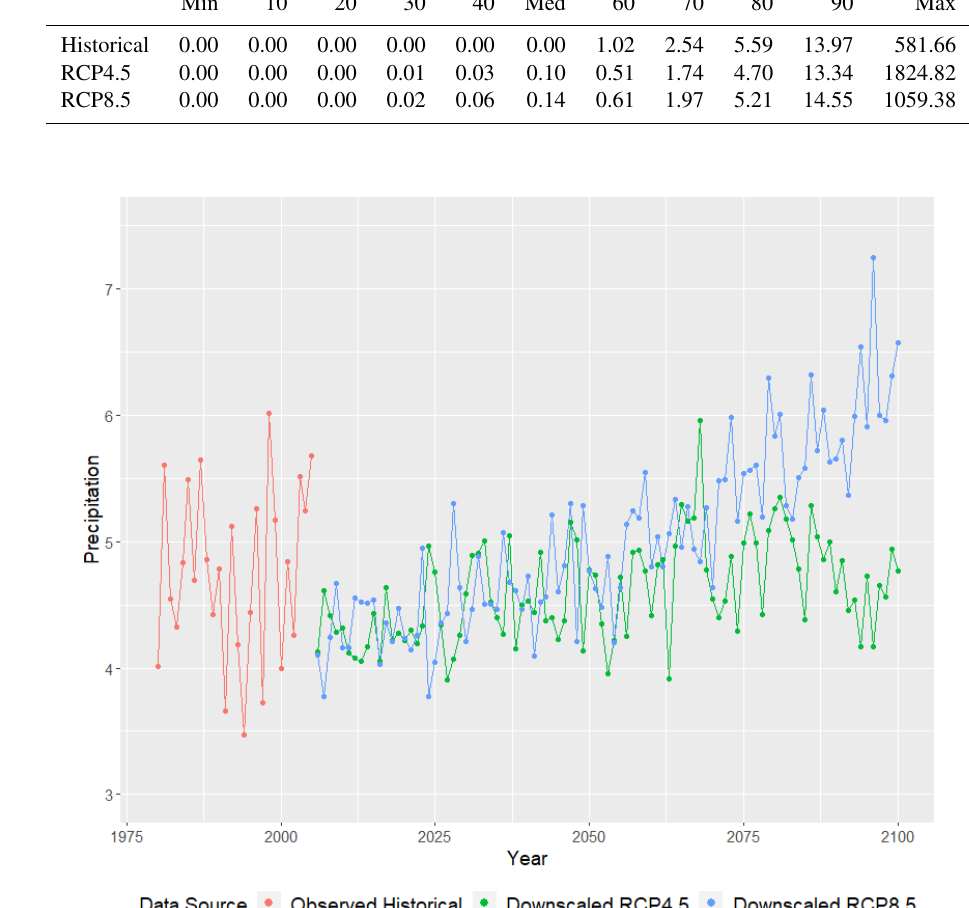
Figure B2. ESM2G-observed historical (GHCN) daily mean precipitation (mm) is plotted as a function of year (1980–2005) in red, while ESM2G RCP4.5 and RCP8.5 downscaled mean precipitation from 2006–2100 is plotted in green and blue, respectively. This figure was created using Wickham